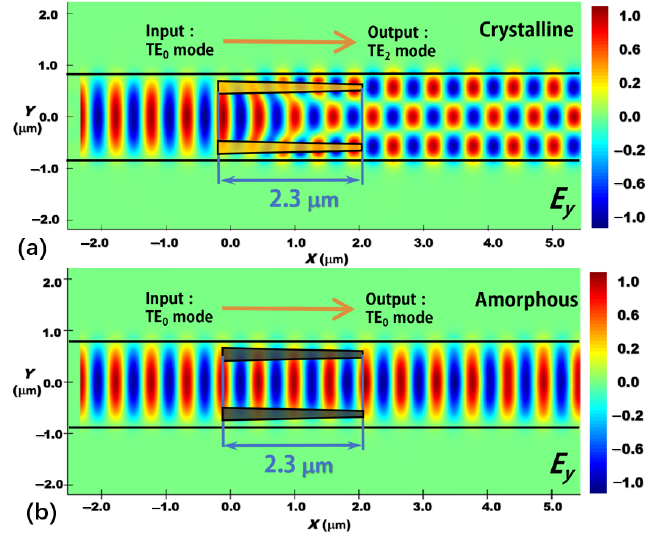
Figure 11. Evolutions of the electric field (dominant component: E y ) along the propagation direction ( x -direction) through a reconfigurable TE 0 -to-TE 2 mode converter. ( a ) The Sb 2 Se 3 layer working at the crystalline state and ( b ) the Sb 2 Se 3 layer working at the amorphous state. The mode conversion length is still 2.3 μm and the working wavelength is 1.55 μm.